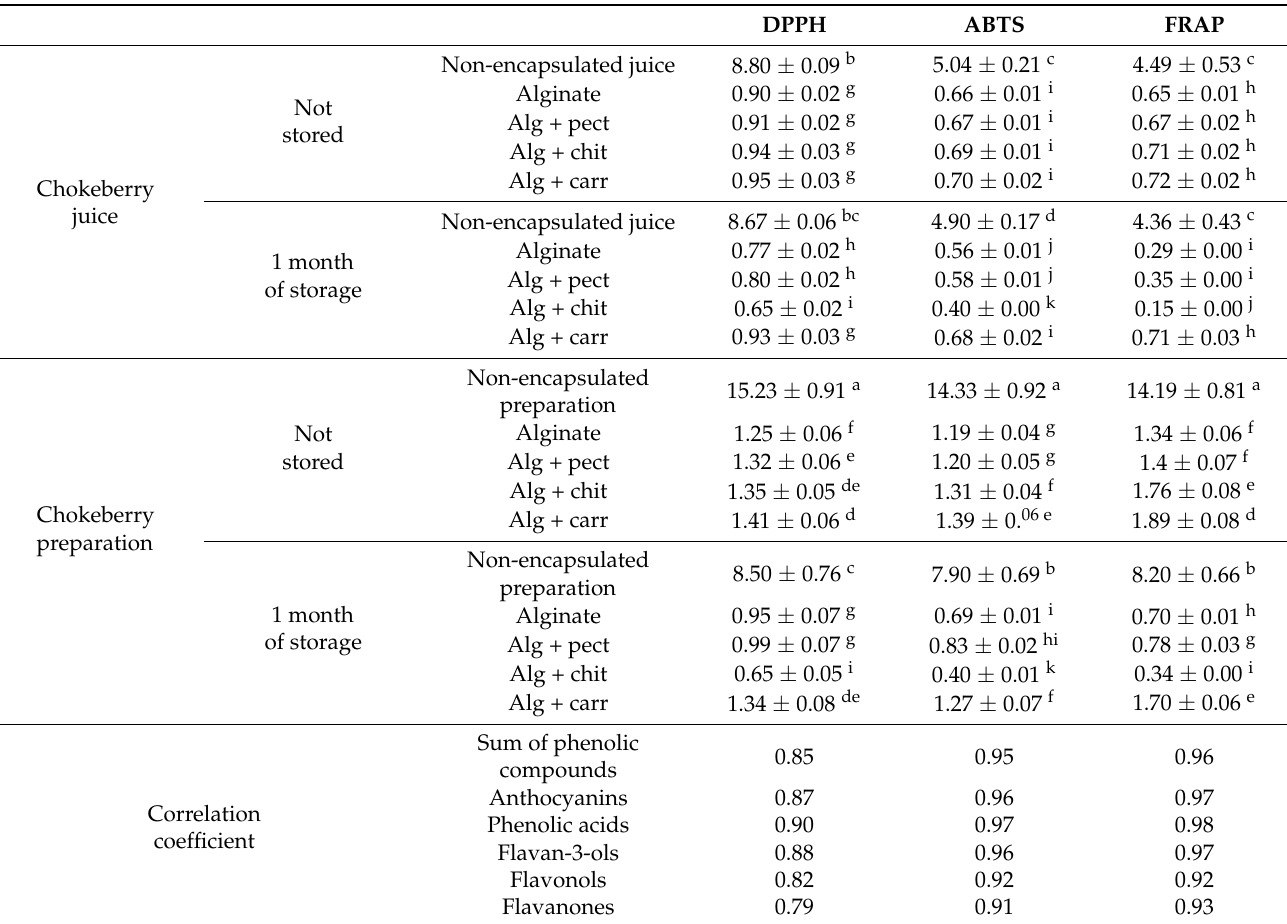
Table 3. Antioxidant capacity (mmol TE/100 g) of microcapsules made with chokeberry juice and chokeberry preparation before and after 1 month of storage at 4 ◦ C and correlation coefficient. DPPH